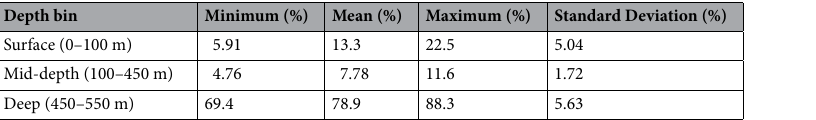
Table 2. Depth bin metrics for Summer 50% migrate case. Minimum, mean, maximum, and standard deviation of the percent of eDNA found in each depth bin over the course of a single